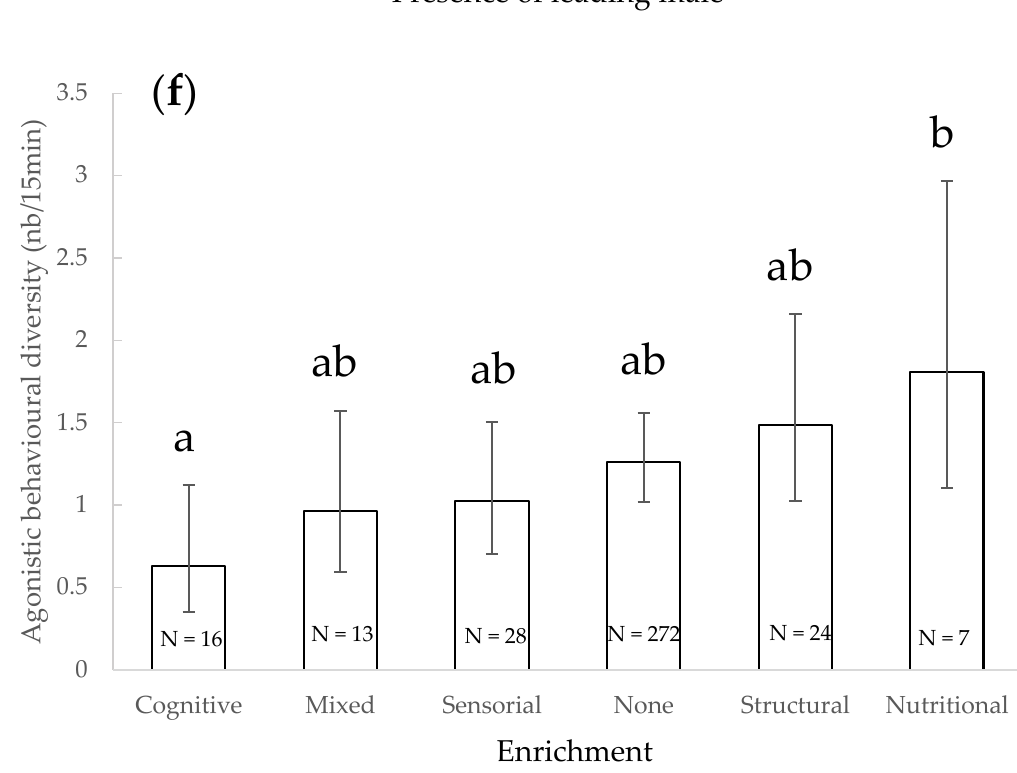
Figure 3. Mean of agonistic behavioural diversity and 95% confidence intervals according to the number of individuals ( a ), observation location ( b ), sex of the individuals ( c ), age of the individuals ( d ), presence of leading male ( e ) and presence of enrichment ( f ). ***: p < 0.001; within each factor, categories that share the same letter do not differ significantly and categories that have no letter in common differ significantly or tend to differ (Wald chi-squared test with sequential Bonferroni correction). N: number of observations.